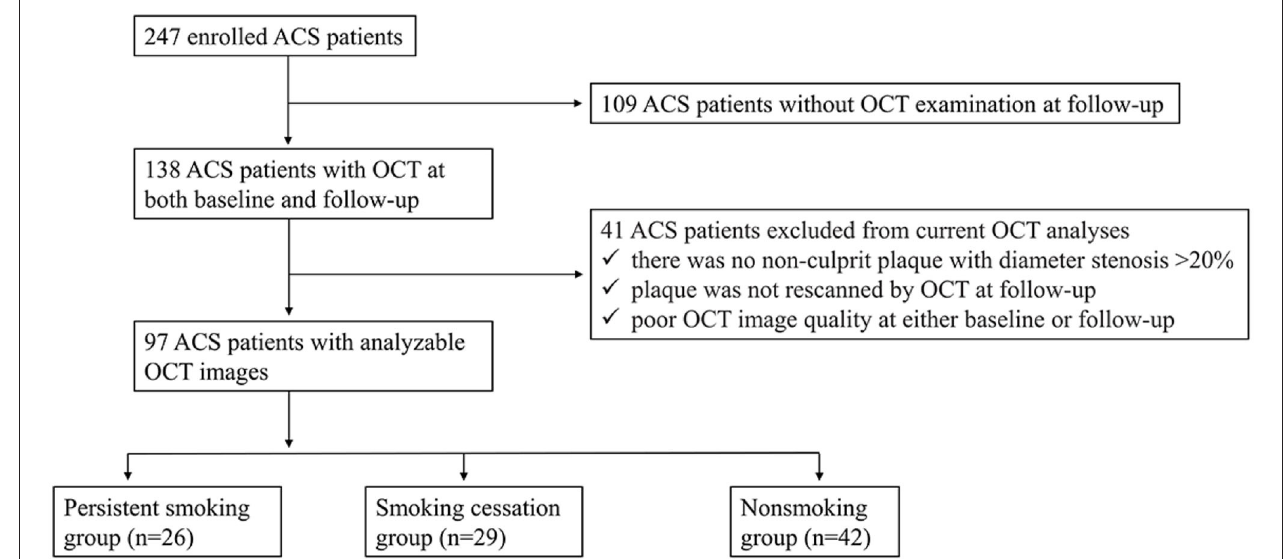
FIGURE 1 | Flow chart showing patient enrollment. ACS, acute coronary syndrome; OCT, optical coherence